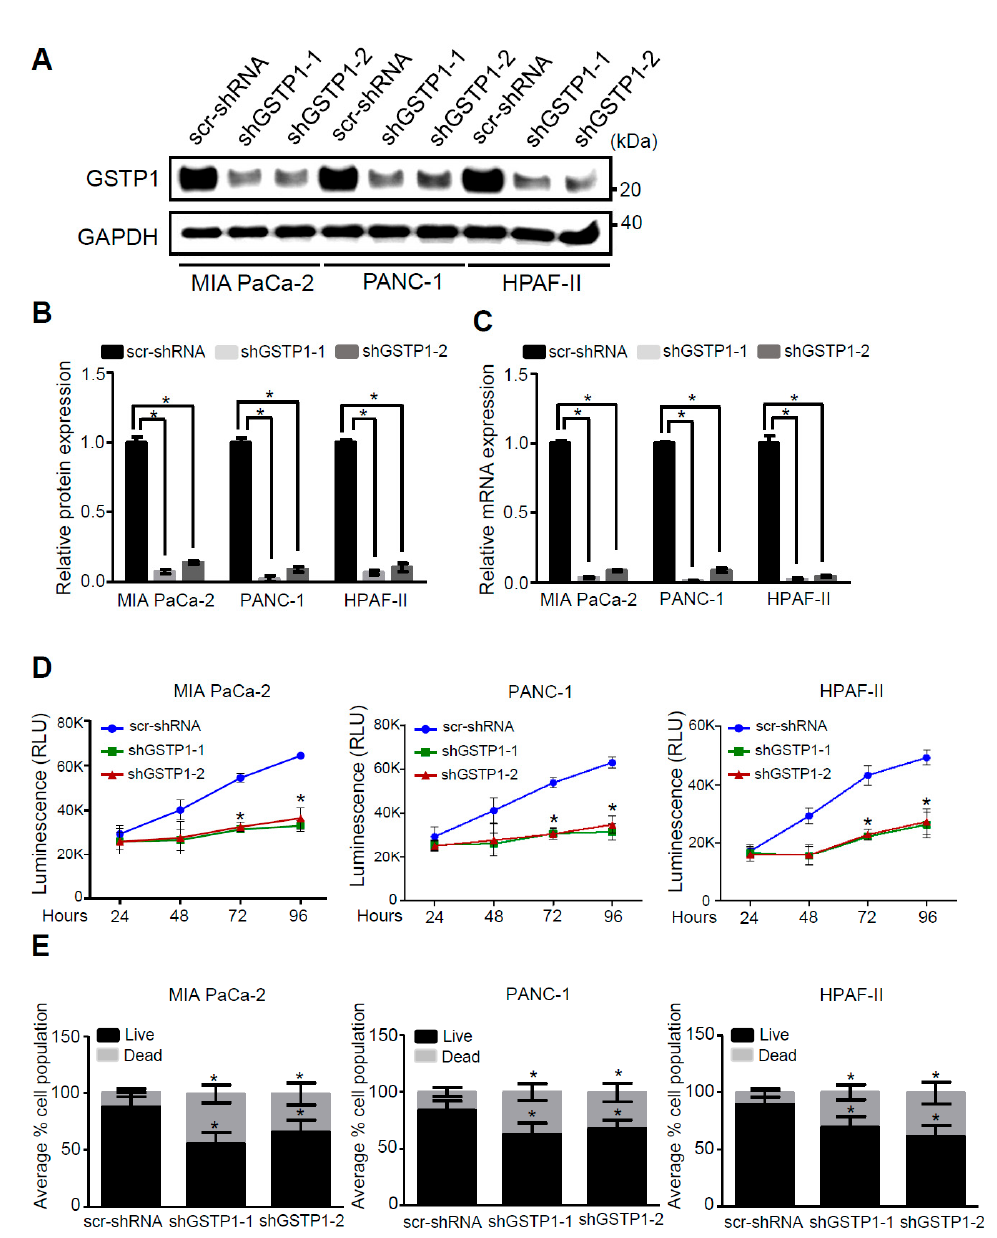
Figure 2. GSTP1 knockdown impairs PDAC cell viability. GSTP1 was knocked down in MIA